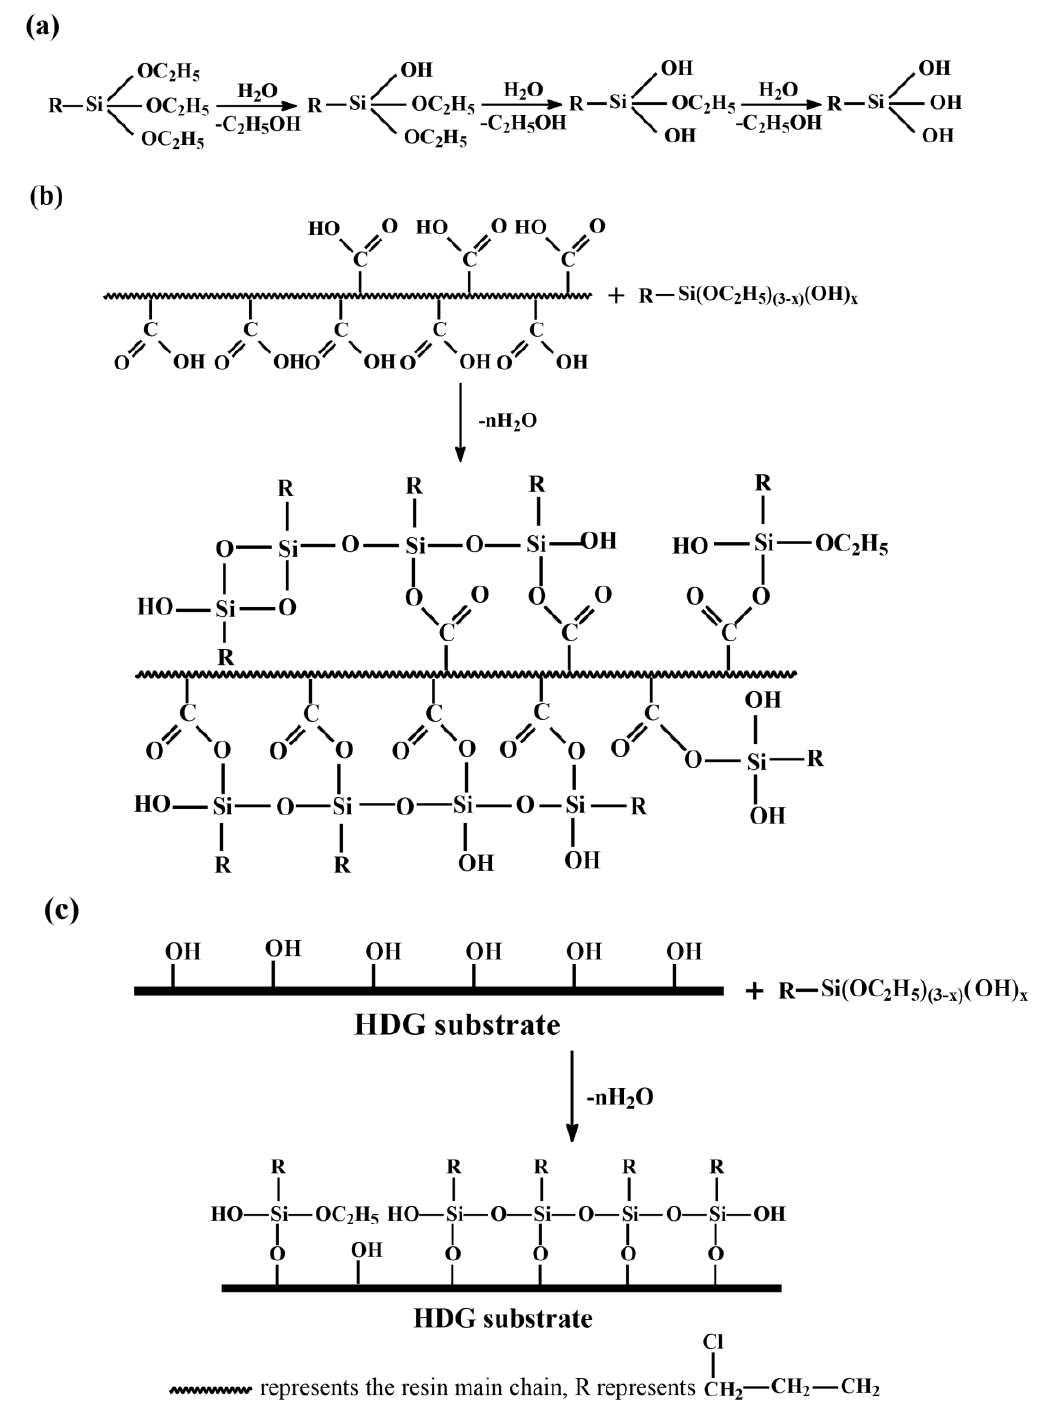
Figure 5. Schematic illustration of the mechanism of ( a ): silane hydrolysis, ( b ): grafted reaction between silanol and resin, and ( c ): bonding reaction between silanol and HDG substrate.